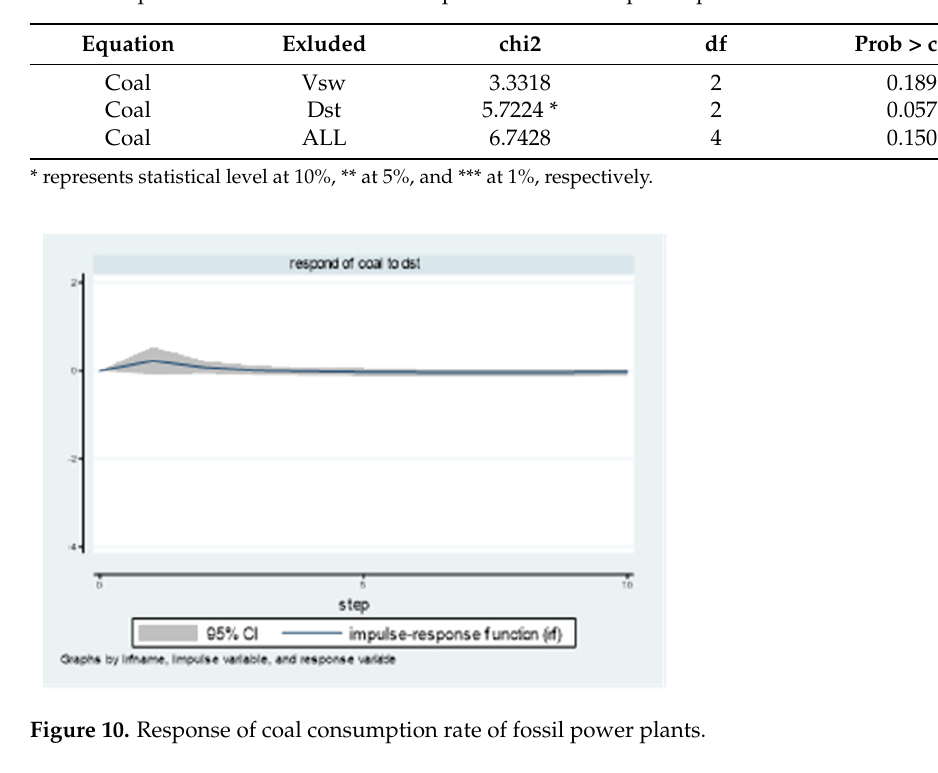
The coal consumption rate of fossil power plants responded positively to the dst index